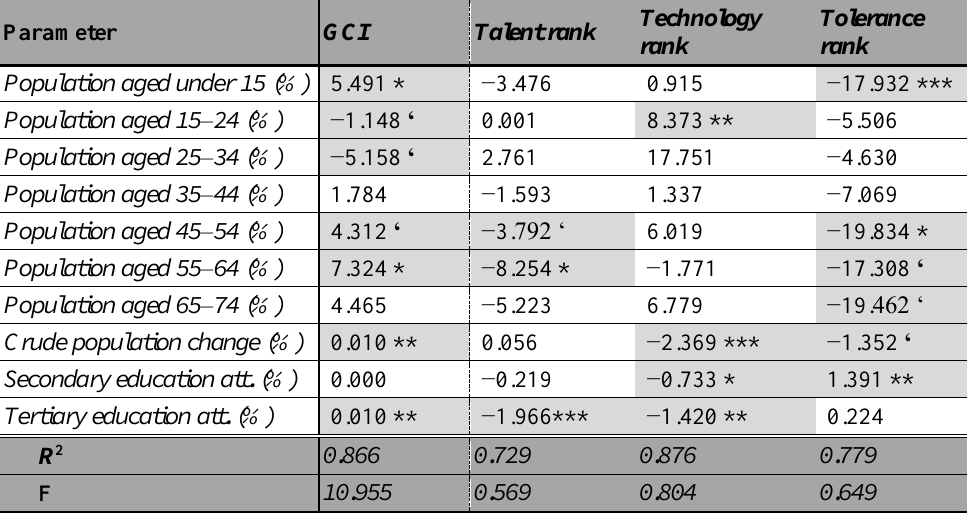
Crude population change (%) 0.010 ** −2.369 *** −1.352 ‘ Secondary education att. (%) 0.000 −0.219 Tertiary education att. (%) 0.010